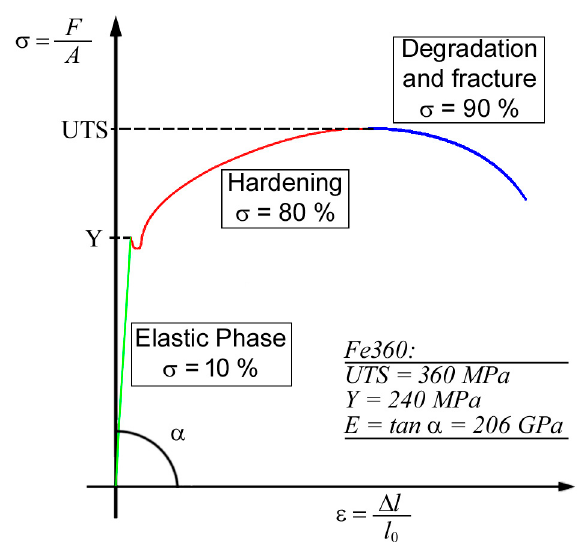
Figure 8. Schematic view of mechanical load- deformation of a metallic material.